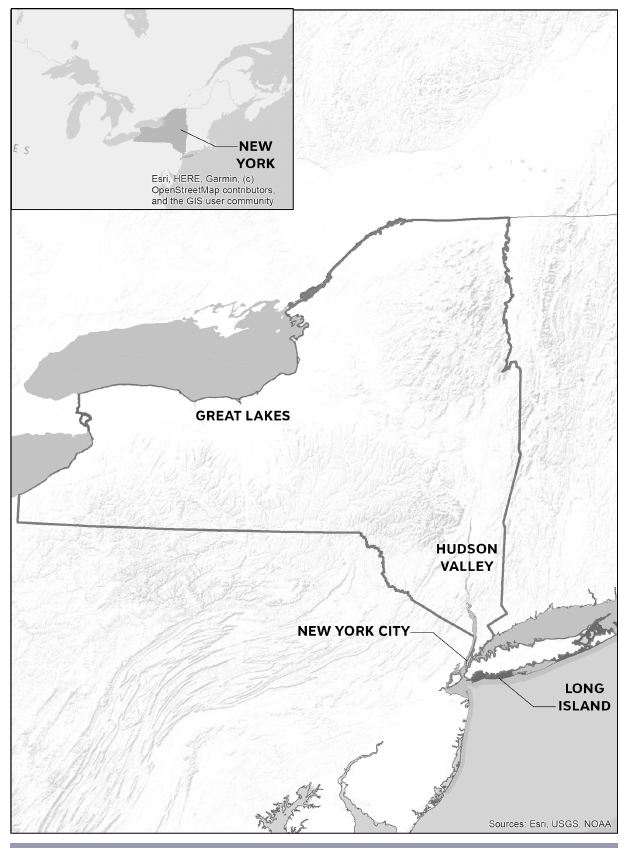
Fig. 1 . New York State and the four shoreline